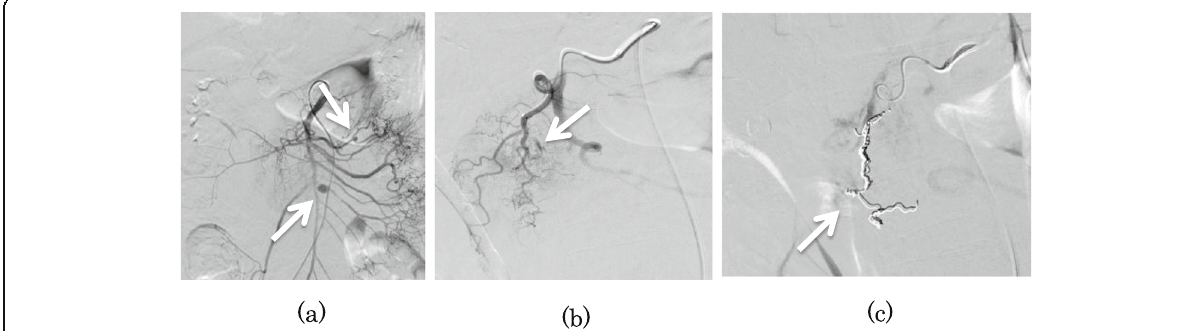
Fig. 2 Angiography revealed two jejunal aneurysms without extravasation ( a ). PDA angiogram showed a slightly enlarged branch artery with extravasation ( b ). Coil embolization was performed from the distal side to the proximal side of the enlarged artery ( c